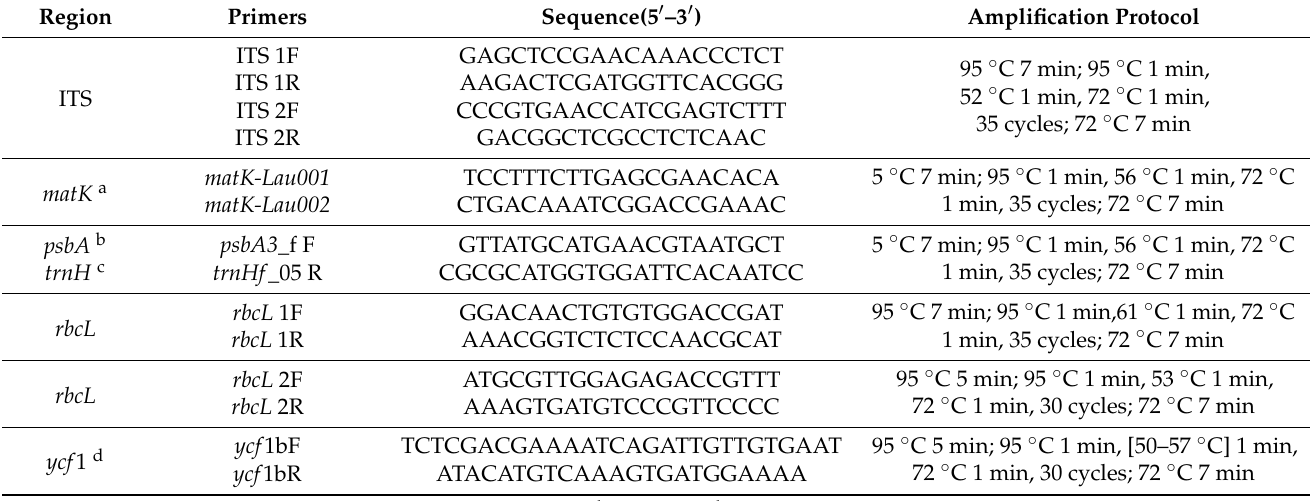
Table 4. Primer sequences applied in DNA amplification of Aniba species and its experimental